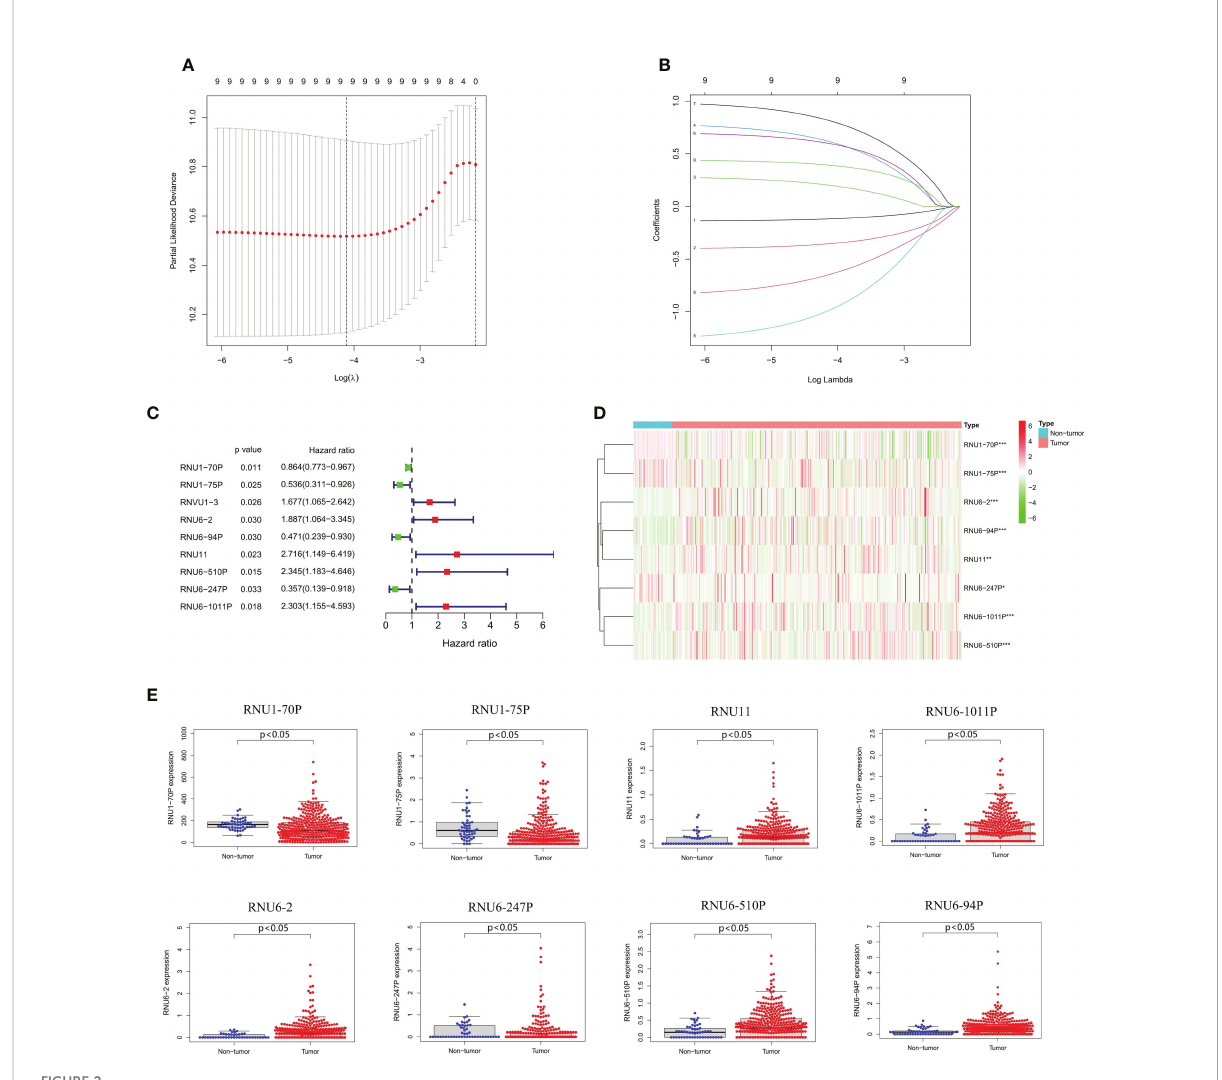
FIGURE 2 Construction of a risk model based on m6A-associated snRNAs. (A) Lasso Cox regression analysis of prognostic snRNA associated with m6A RNA regulators. (B) Cross-validation of parameter tuning and selection in the LASSO model. (C) Forest plot of predictive prognostic snRNAs associated with m6A RNA regulators. (D) Heatmap of eight m6A-associated snRNA expression. (E) Expression of eight m6A-associated snRNAs between non-tumor and tumor